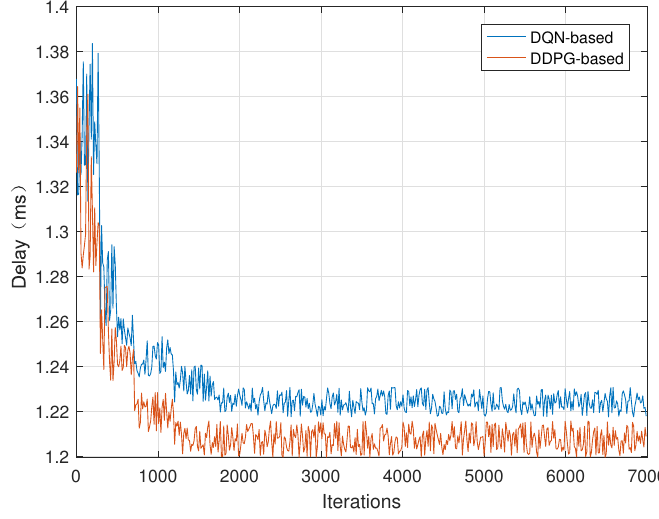
Figure 7. The delay dynamics of each iteration of the DQN-based and DDPG-based algorithms during the training process, where the blue curve represents the delay dynamics of the DQN-based algorithm and the red curve represents the delay dynamics of the DDPG-based algorithm.